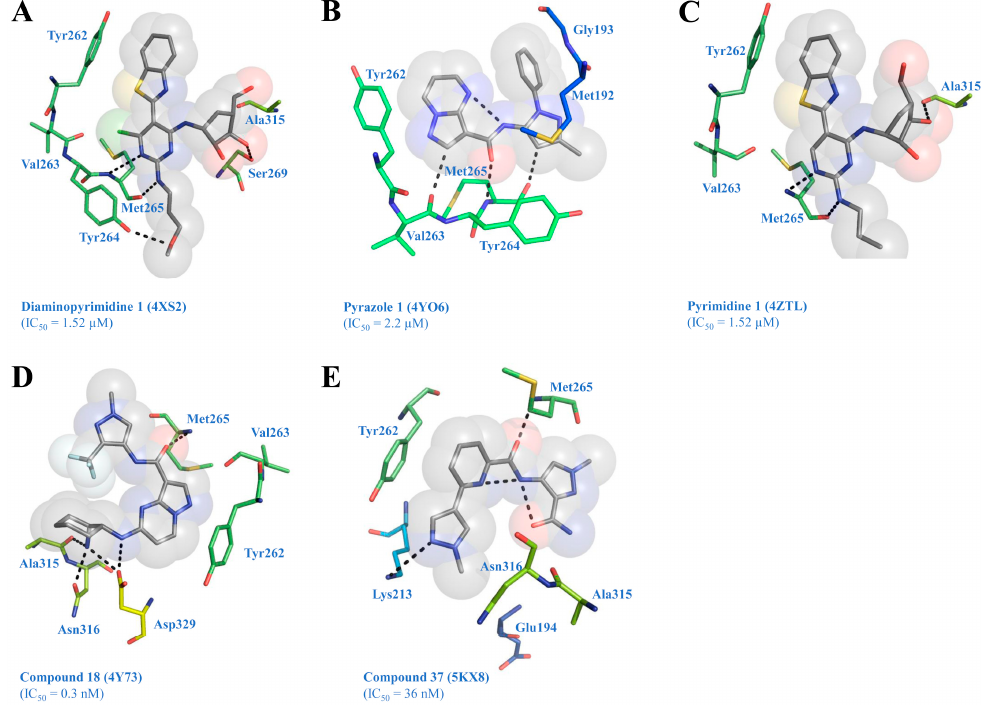
Figure 5. Interactions of co-crystallized inhibitors with IRAK4 residues. The figure describes the typical interactions that the co-crystallized ligands ( A ) diaminopyrimidine 1, ( B ) pyrazole 1, ( C ) pyrimidine 1, ( D ) compound 18, and ( E ) compound 37 make with the catalytic site of IRAK4. The most unusual interaction was observed between the lead compound pyrazole 1 and IRAK4. Pyrazole 1 forms three H-bonds with the hinge backbone region, in contrast with other inhibitors, which form one. All inhibitors bind IRAK4 in a nearly planar orientation, which is a crucial feature required for π -stacking with the gatekeeper Tyr262. IC 50 = inhibitory concentration.